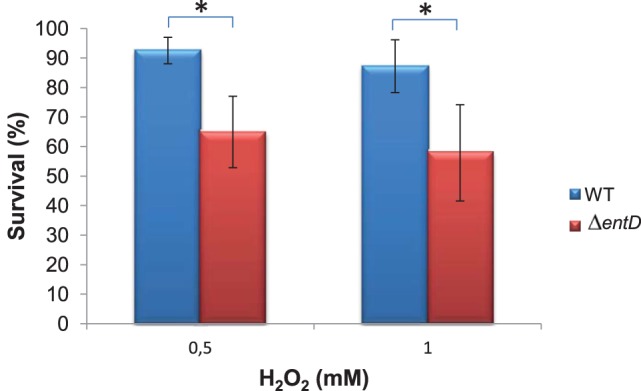
Survival of wild-type and ΔentD mutant cells toward external hydrogen peroxide insult. Cells were grown in liquid culture to the mid-exponential growth phase, and subjected to 0.5 and 1 mM H2O2, respectively. Colony forming units per mL were counted and expressed as (N/N0) × 100. Errors bars represent the standard deviation from 6 independent measures. Significant differences (p < 0.05) between wild-type and mutant strains are indicated with asterisks.